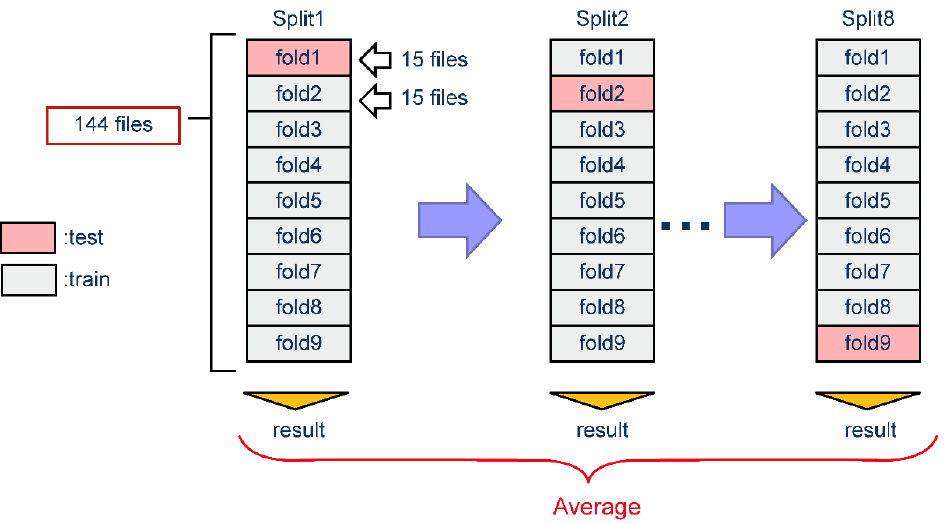
Figure 3. Cross evaluation schematics.